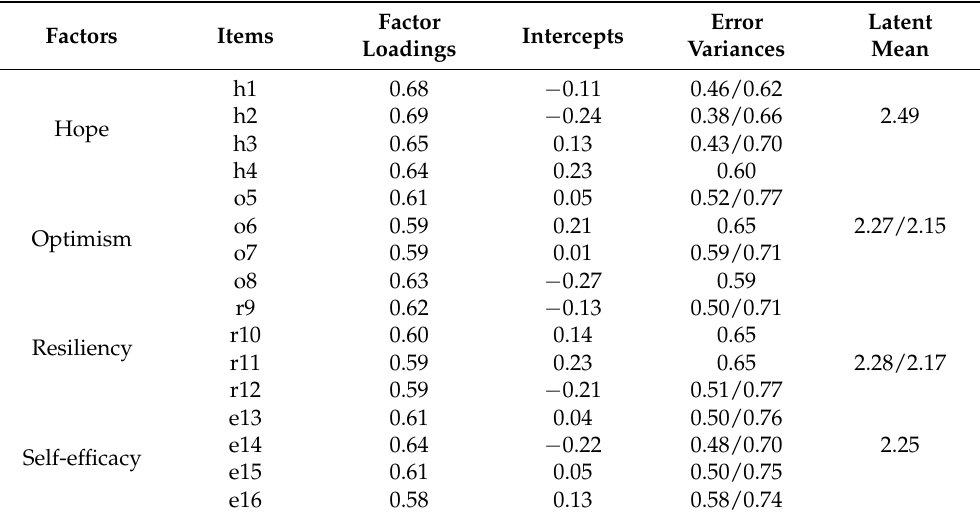
Table 3. Invariant and non-invariant factor loadings, intercepts, error variances, and mean differences between genders.